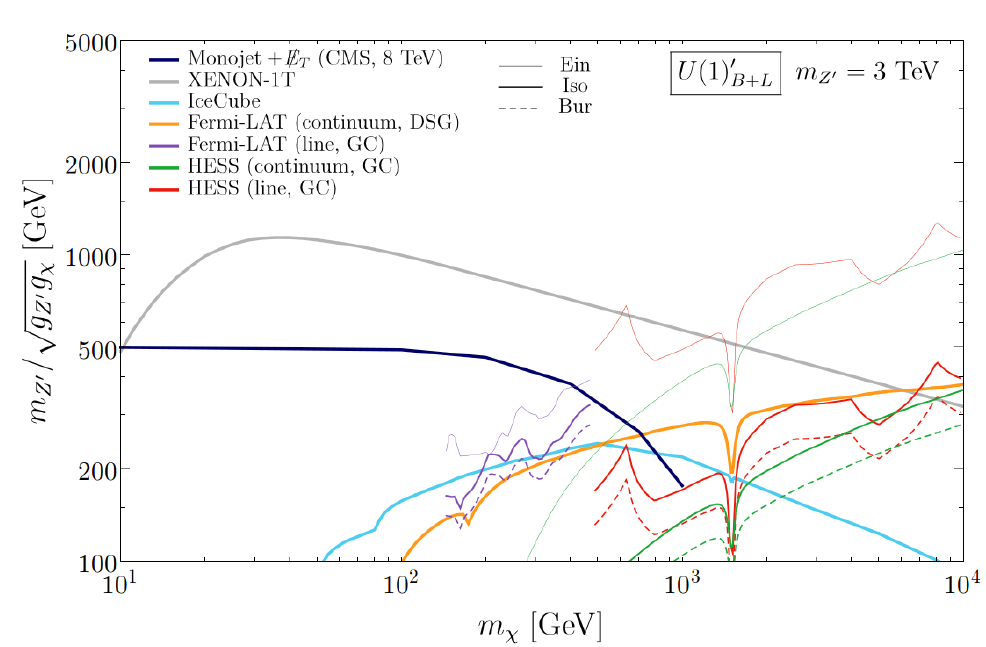
Figure 11 . The same as in (cid:12)gure 10, shown for the U(1) 0